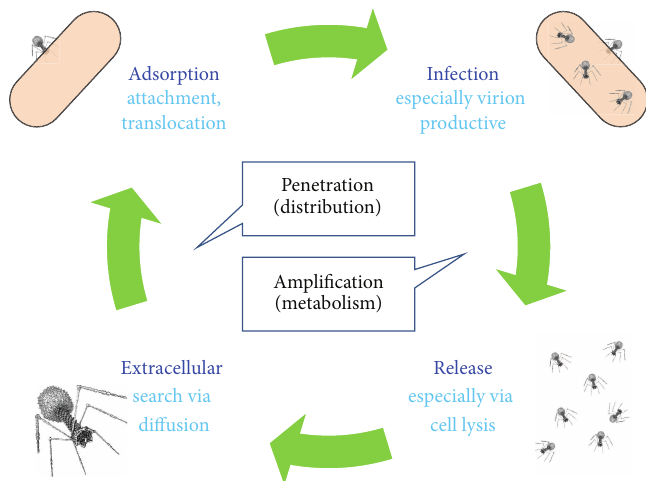
Figure 3: Life cycle of an obligately lytic bacteriophage. As this is a cycle, the “beginning” is arbitrary. A successful infection nonetheless progresses through adsorption, infection, release (here via lysis), and a period of extracellular “search” for new bacteria to infect. Deviations from this life cycle can include inactivation during the extracellular stage, a failure to successfully adsorb, and various forms of phage inactivation that can occur during infection, including as explicitly mediated by bacterial cells [17, 164]. Though lytic phages are released via lysis, other phages exist, most notably filamentous phages such as phage M13, that instead are released from infected bacteria chronically. Generally such nonlytic phages are not used for phage therapy. Another variation on the phage life cycle is lysogenic cycles, which are nonvirion productive extensions of the infection stage. Only temperate, particularly not obligately lytic phages display lysogenic cycles, and temperate phages typically also are not among the first choice for phage therapy purposes [222]. Shown too, in the middle, is reference to pharmacological aspects of phage infections. Particularly these are distribution throughout body tissues that can occur while in the free phage state (a.k.a., phage penetration to target bacteria) along with amplification of phage numbers in situ as can occur as a consequence of phage infection of bacteria, which is a component of what pharmacokinetically is known as